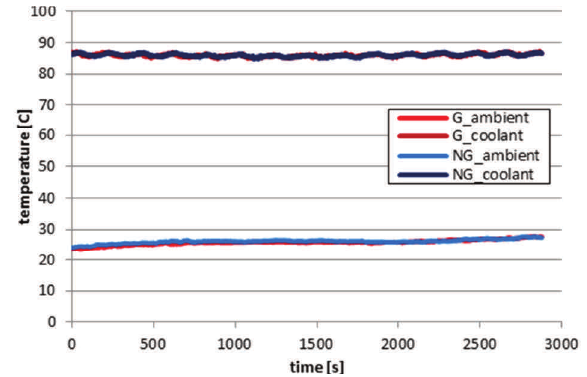
Fig. 2. Air temperature in intake manifold and coolant temperature in the cylinder head